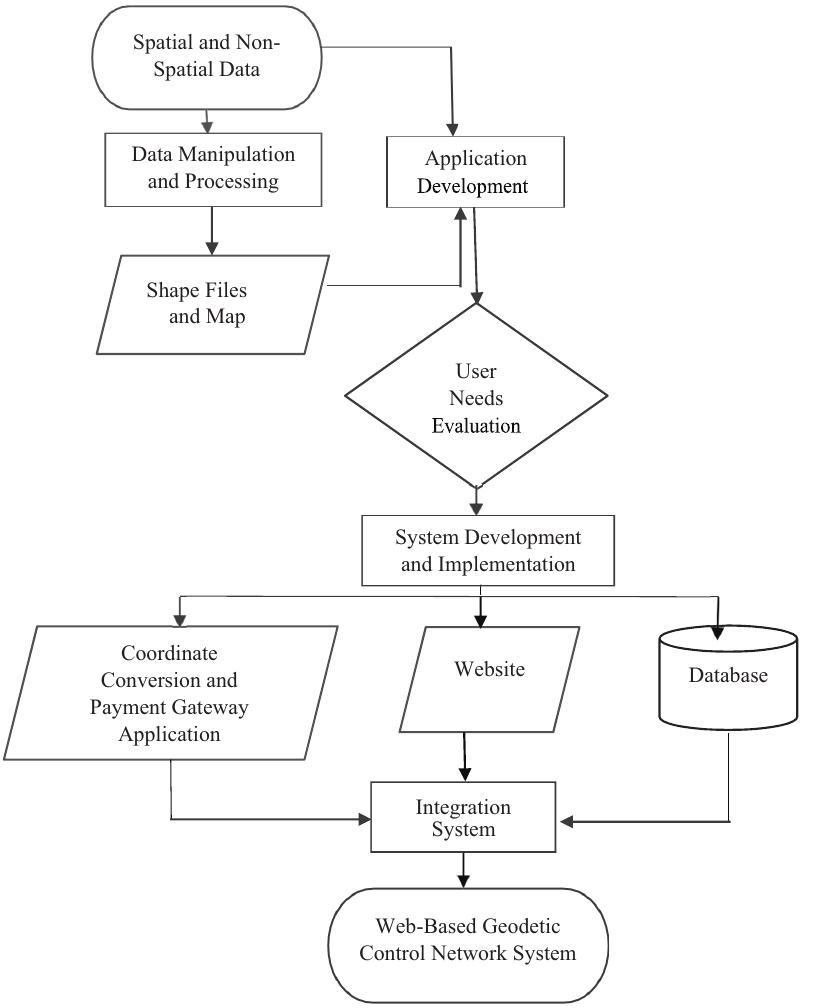
Figure 2. Approach adopted for the study